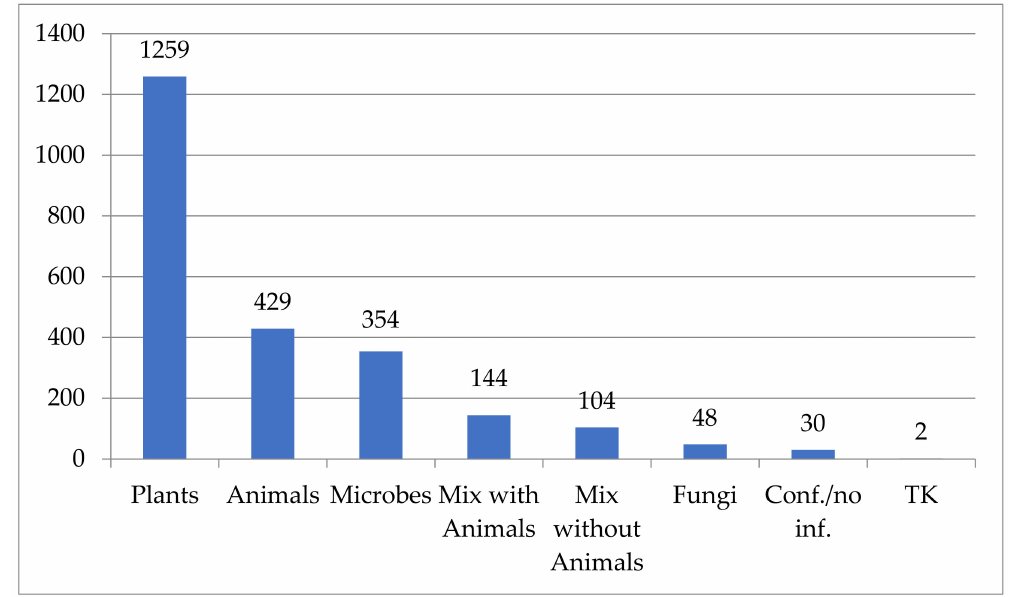
Figure 3. Distribution of genetic resources and traditional knowledge covered by the IRCC, as of 31 May 2021.